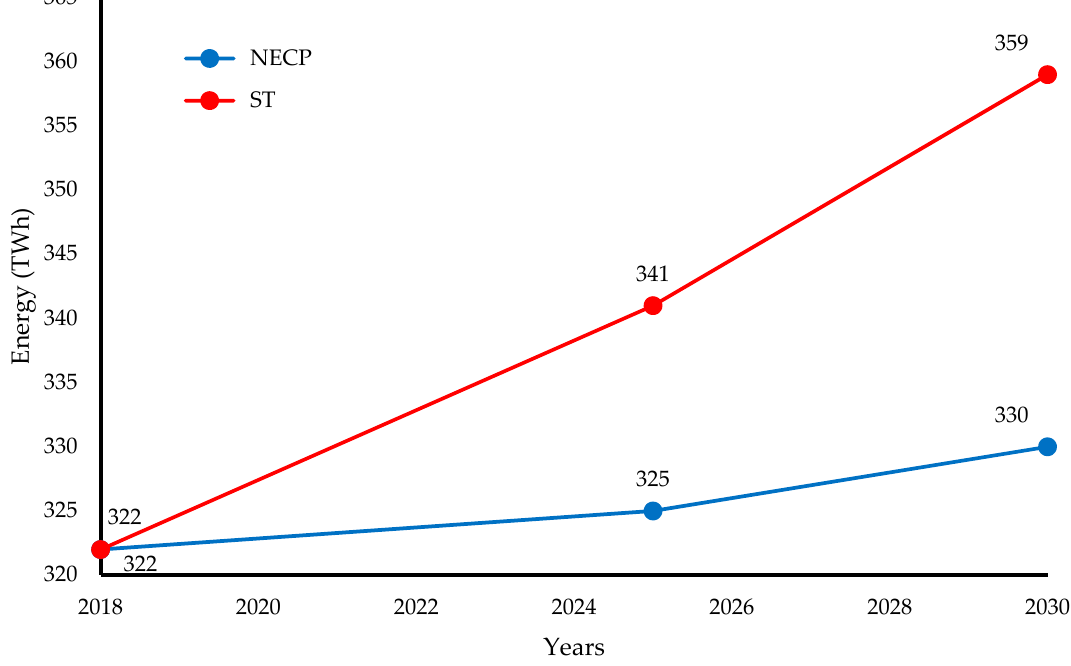
Figure 6. Energy demand versus time for NECP and sustainable transition (ST) scenarios [19].